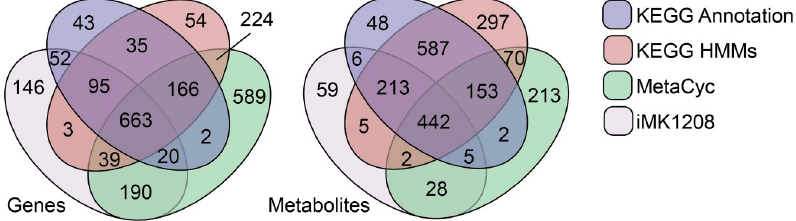
Fig 3. Venn diagrams comparing genes and metabolites between the three de novo draft reconstructions and